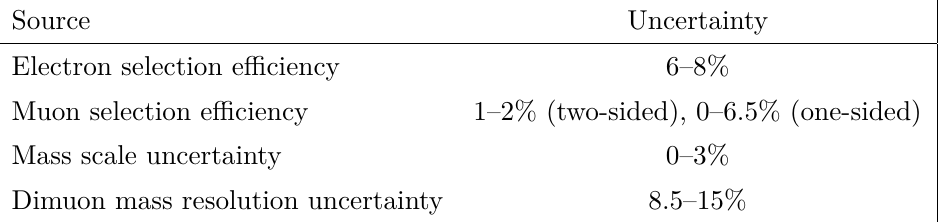
Table 2 . Sources of systematic uncertainties considered in the search for resonant signals and their relative